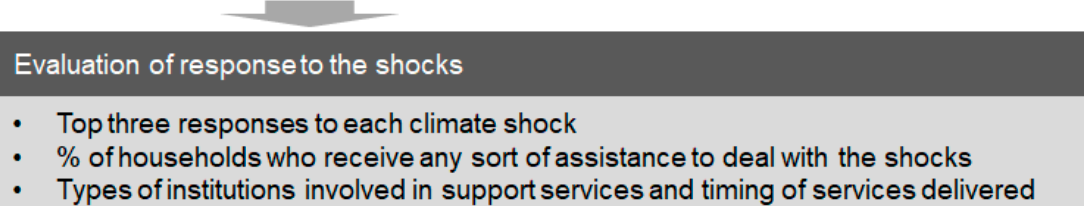
Figure Figure 2. Methodological flow chart for assessing climate shocks and responses in Karnali-Mahakali basin.